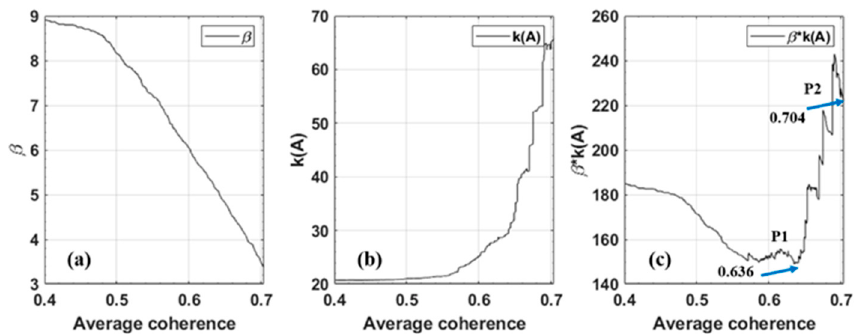
Figure 4. The process for automatic selection of candidate interferograms. Plots of ( a ) average coherence β , ( b ) condition number, ( c ) upper-error bound vs. the interferometric-average-coherence threshold.